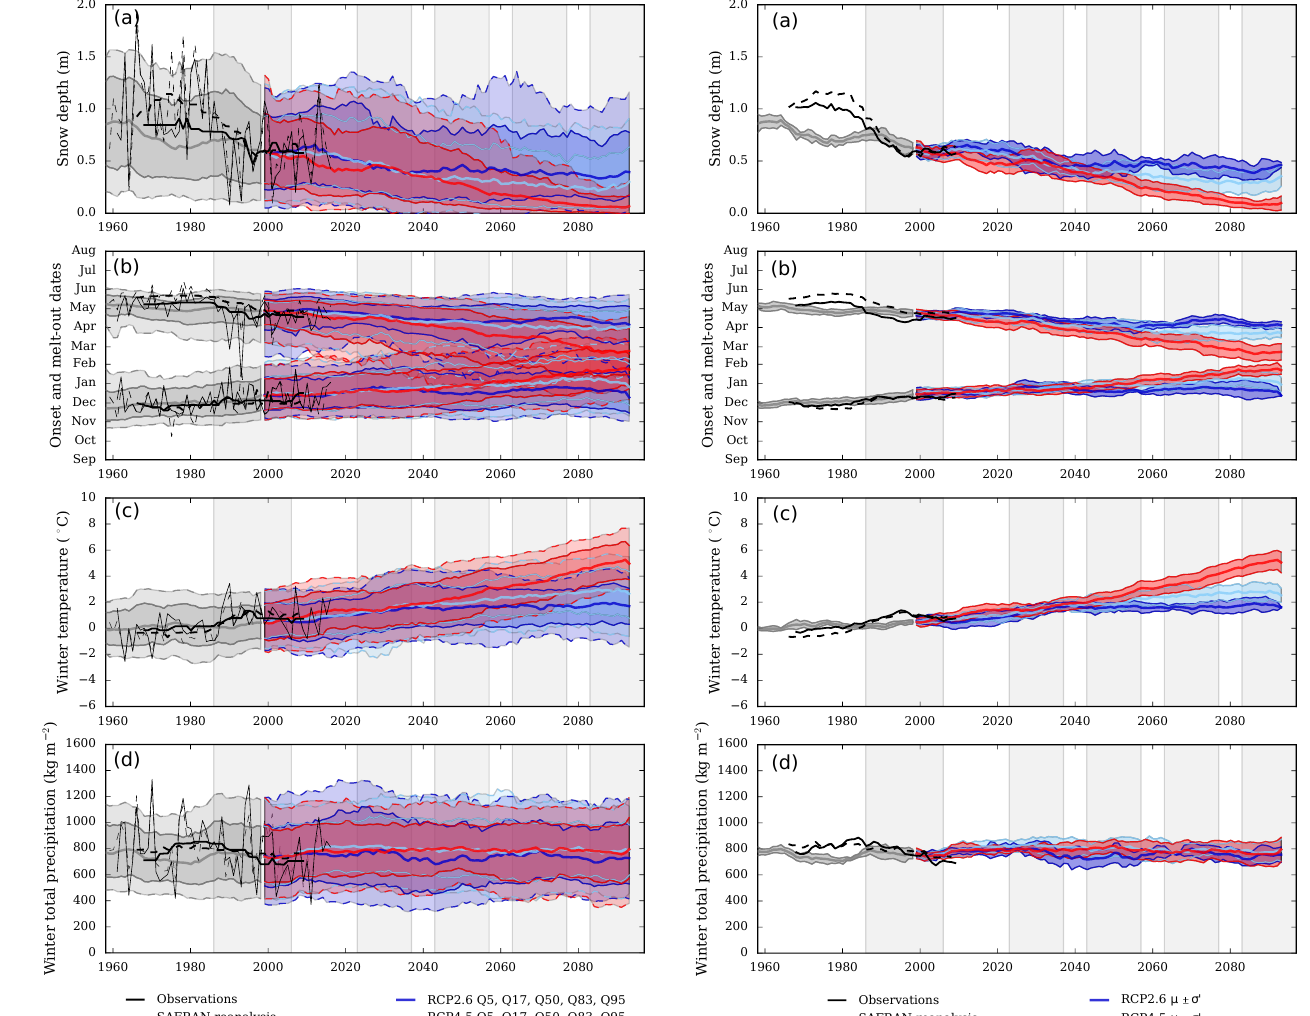
hibits a mean increase of + 1 . 0 ± 0 . 3 ◦ C regardless of the RCP. The results for the three RCPs already differentiate for the 2050 lead time, and the difference continues to widen until the end of the century with + 1 . 4 ± 0 . 4 ◦ C for RCP2.6, + 2 . 3 ± 0 . 6 ◦ C for RCP4.5 and + 4 . 6 ± 0 . 7 ◦ C for RCP8.5. While the temperature trends are unequivocal, there is no